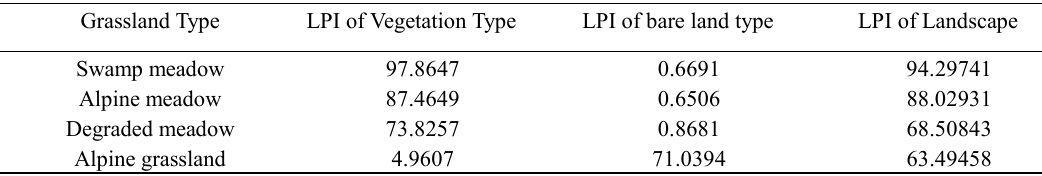
Table 3. Statistical table of maximum patch index of four kind of grassland